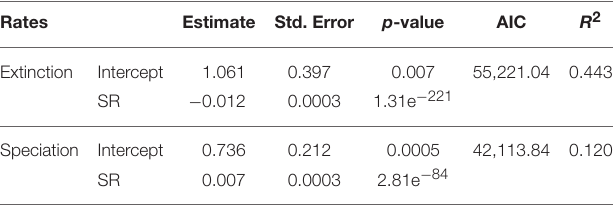
TABLE 4 | Regression coefficients based only on quadratic models quantifying the relationship between diversification rates (i.e., extinction and speciation) and SR. Rates Estimate Std. Error p -value AIC R 2 Extinction